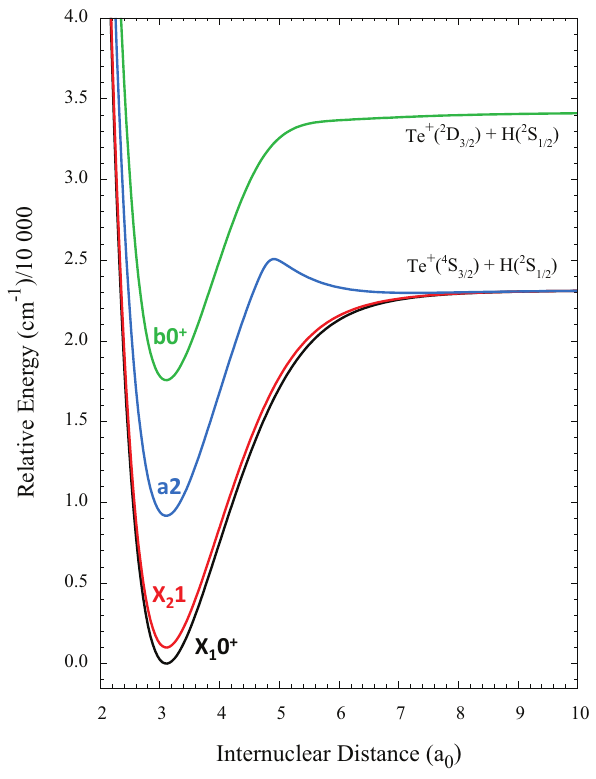
Figure 1. Low lying electronic states of TeH + . Figure generated from